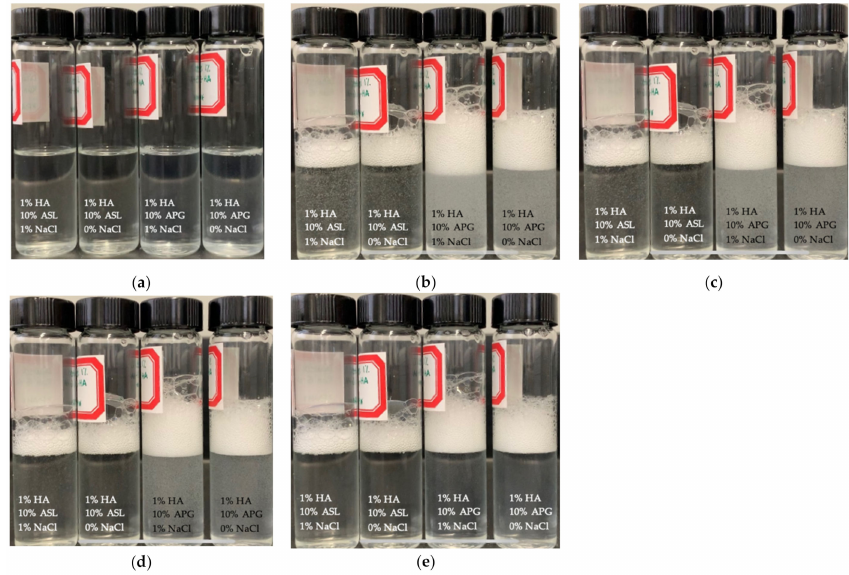
Figure 11. Effects of NaCl concentration on foaming for samples containing HA with ASL and HA with APG, measured at: ( a ) T=0 s; ( b ) T=15 s; ( c ) T=30 s; ( d ) T=1 min; ( e ) T=5